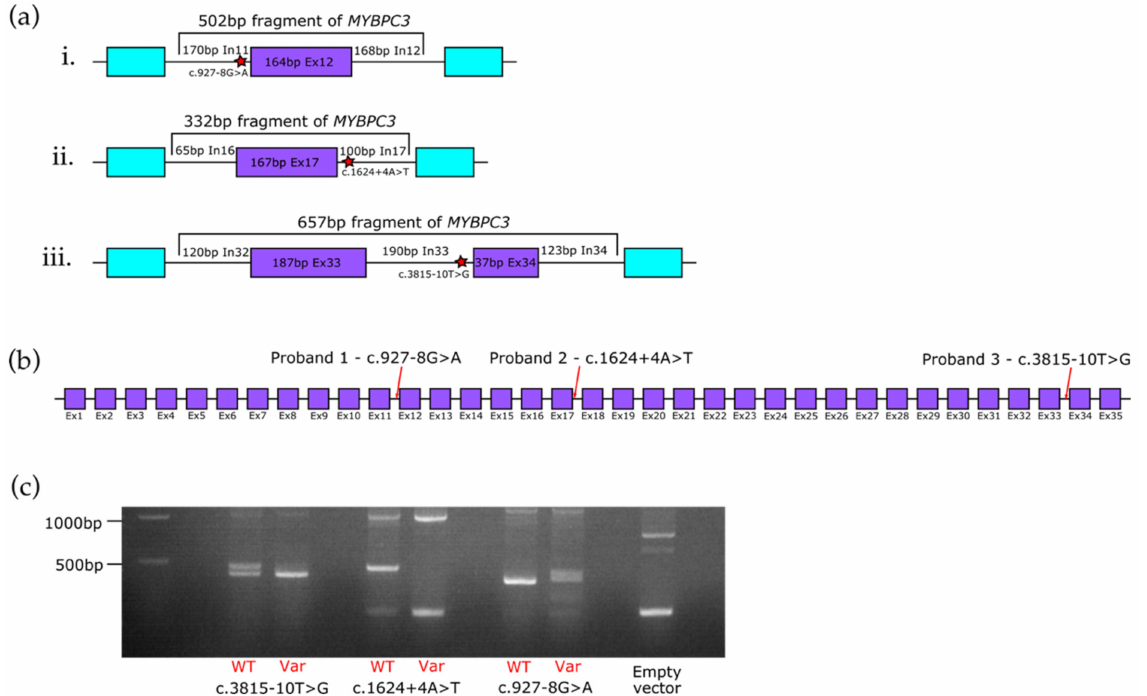
Figure 1. MYBPC3 intronic splice variants in three probands with hypertrophic cardiomyopathy. ( a ) Schematic of the minigene constructs used to test the pathogenicity of MYBPC3 splice variants i . c.927-8G>A, ii . c.1624+4A>T and iii . c.3815-10T>G. MYBPC3 exons are shown in purple. Endogenous minigene exons are shown in light blue. The locations of the splice site variants are indicated by red stars. Ex = exon, In = intron. ( b ) Location of MYBPC3 splice variants analysed in this paper and the probands in which the variants were identified, using the reference transcript NM_000256. Purple boxes refer to exons (Ex), black lines refer to introns. ( c ) Representative RT-PCR results showing the outcome of the minigene assays. Identities of RT-PCR products were confirmed by Sanger sequencing. High molecular weight bands above 500 bp correspond to unspliced vector DNA contamination. WT = wild type, Var = variant. n =